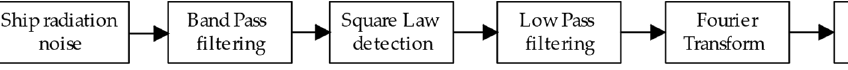
Figure 1. The process of the DEMON method.